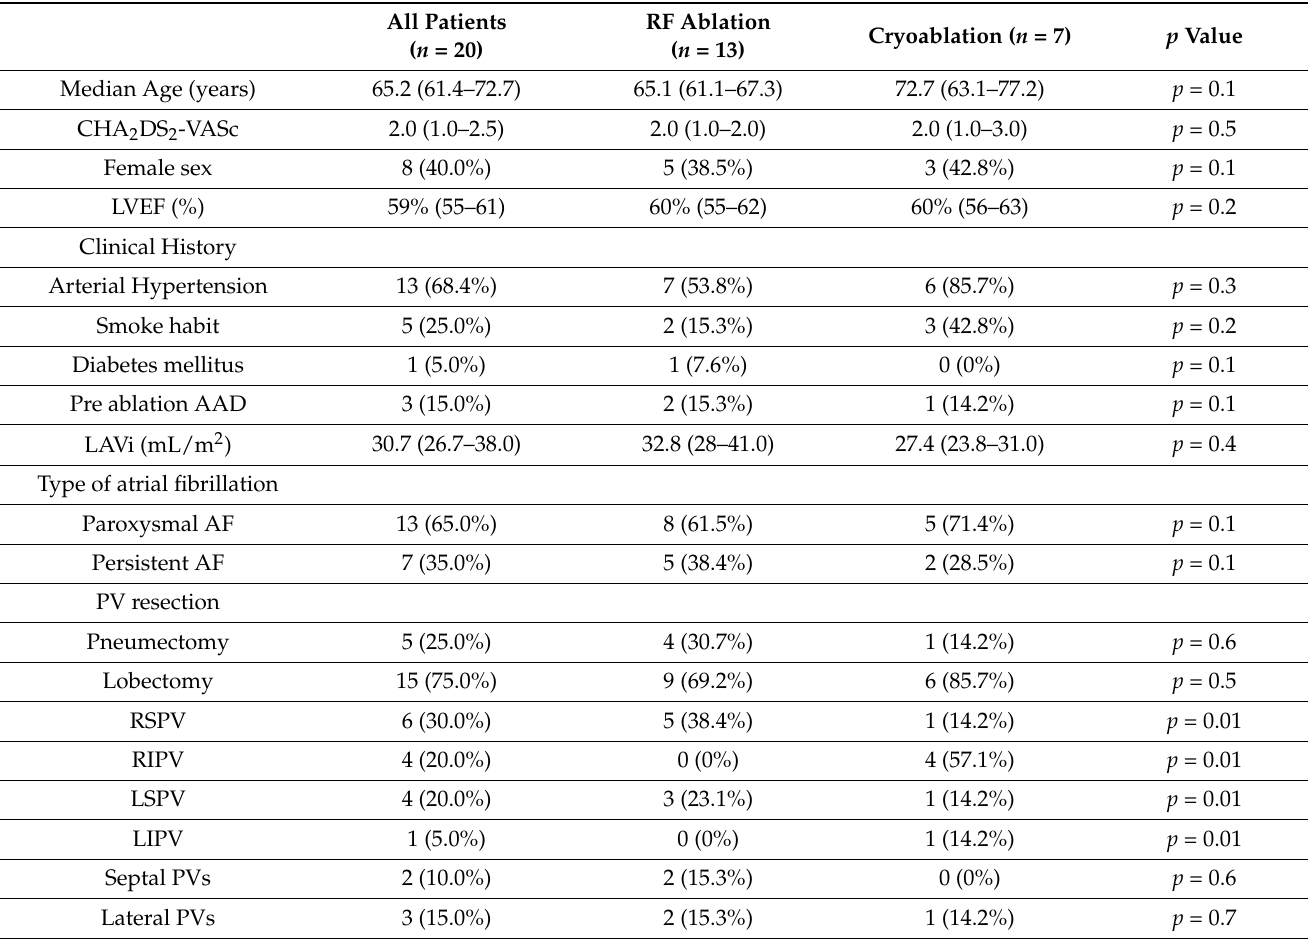
Table 1. Differences in baseline characteristics between patients treated by means of radiofrequency pulmonary vein isolation or